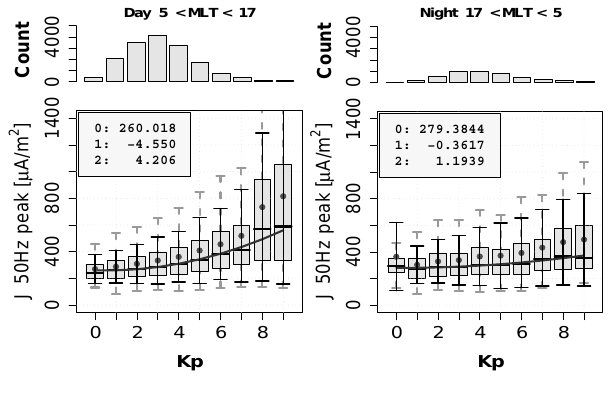
Fig. 9. K p dependence of the the box indicates the median value for the respective bin (the mean is marked by a small circle), the box reflects quartiles and the dashed vertical lines the standard deviation. The numbers in the legend denote the coefficients of the regression parabola.